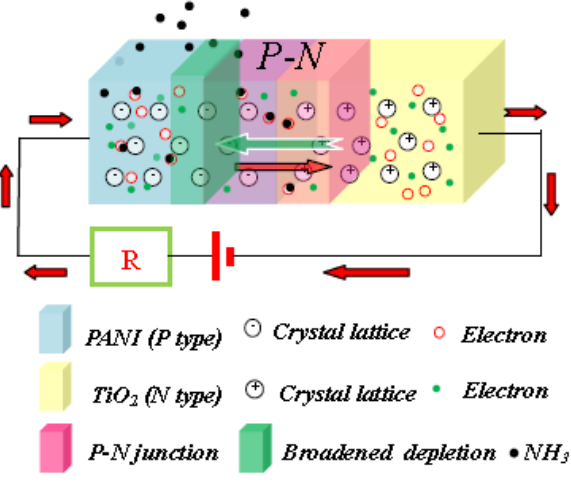
on the depletion layer of TiO 3